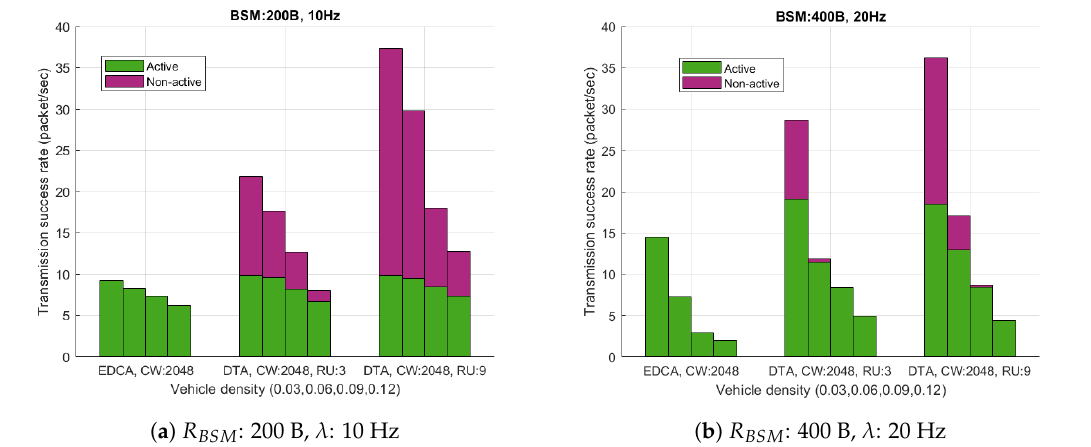
Figure 11. Ratio between active BSM and non-active